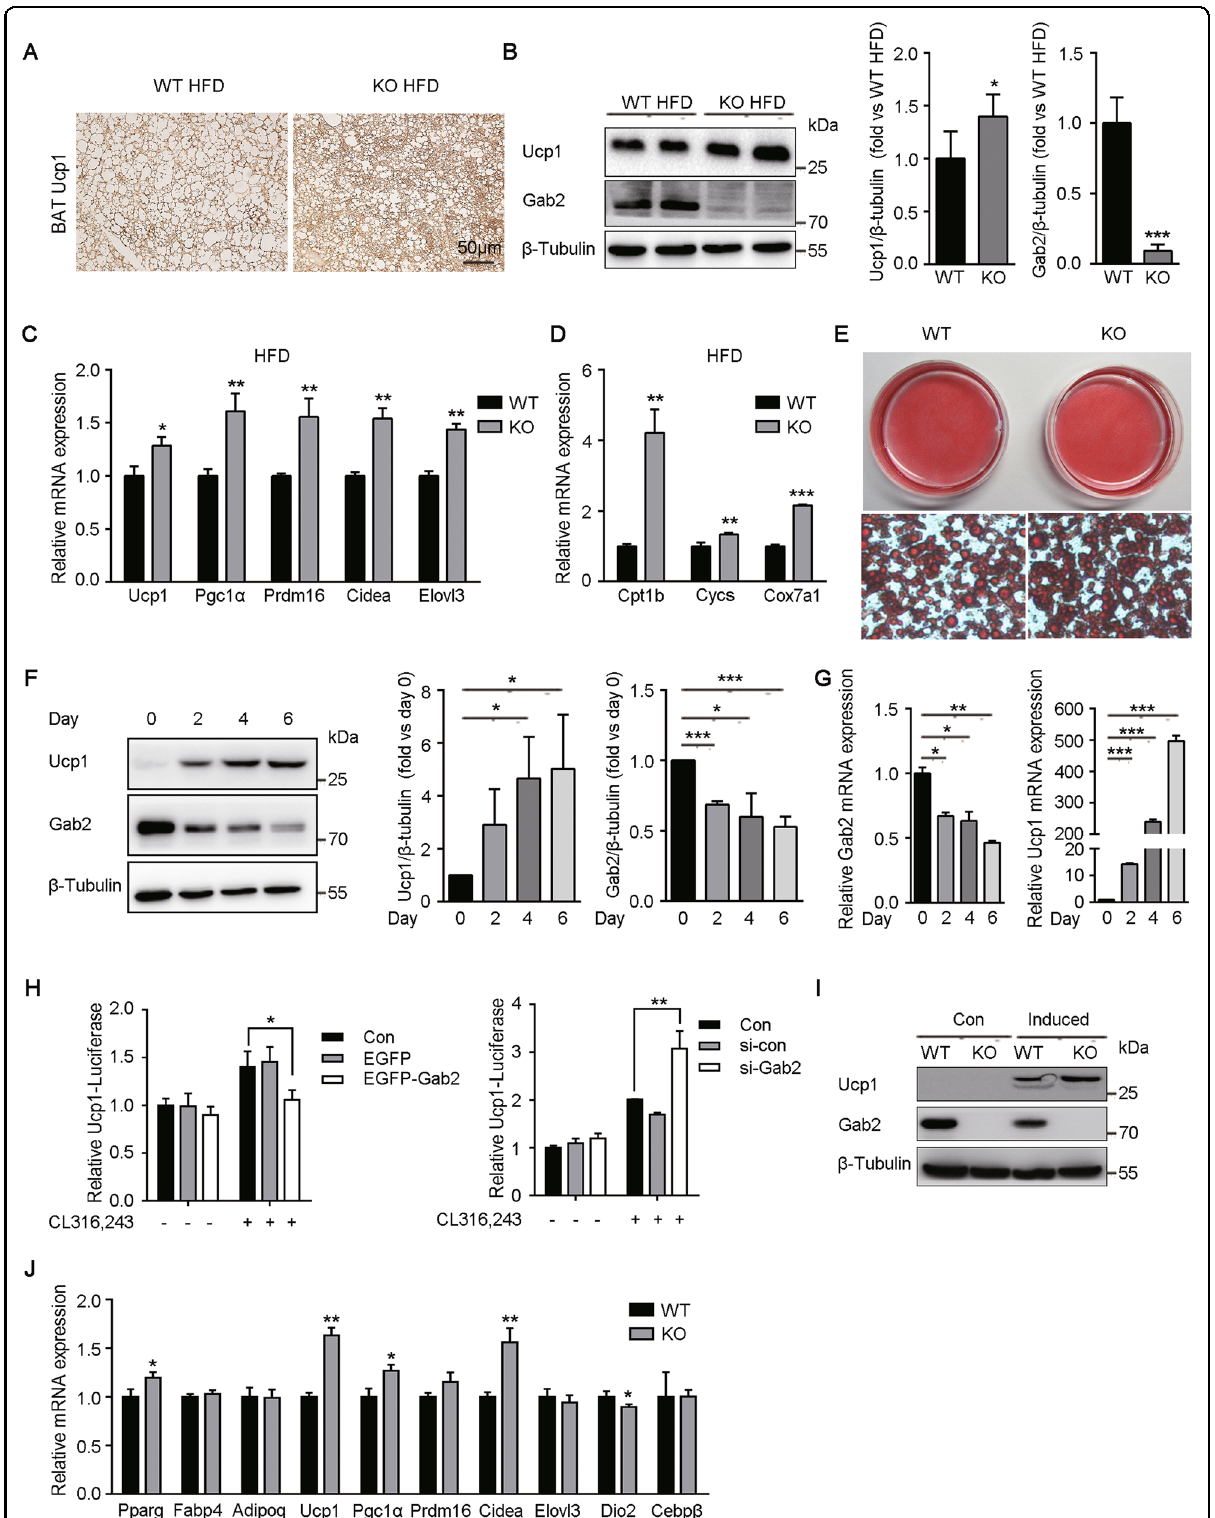
Fig. 5 (See legend on next